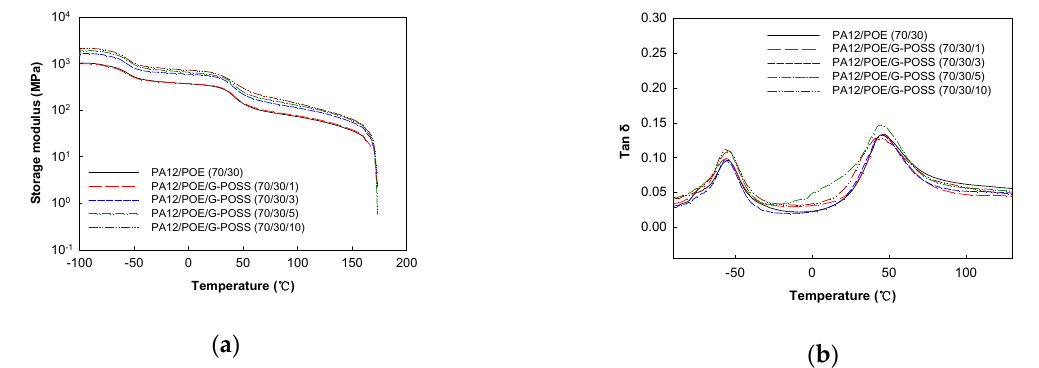
Figure 5. Variation of ( a ) storage modulus; ( b ) tan δ with temperature of samples.